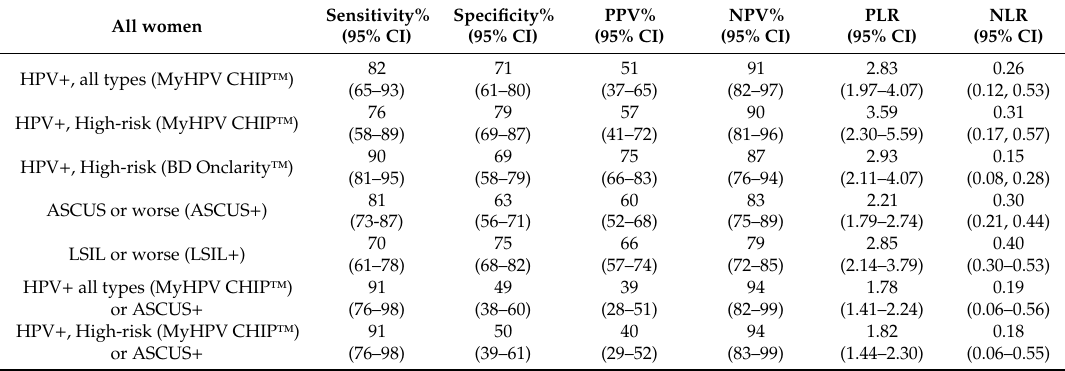
Table 12. Performance of HPV test combinations and cytology for the detection of CIN2 or